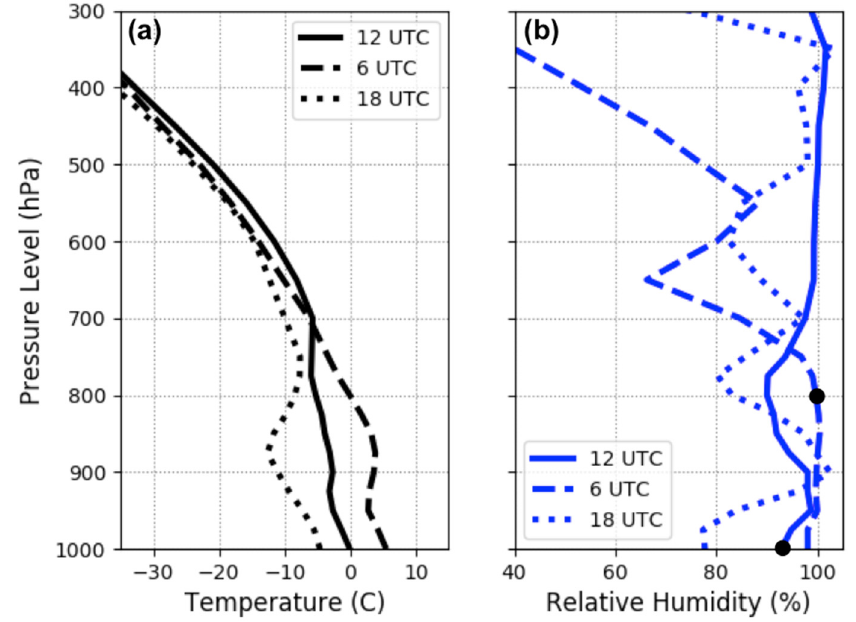
Figure 8. Profiles of temperature ( a ) and relative humidity ( b ) from the ERA5 reanalysis for 27 De- cember 2018 at 1200 UTC (solid line), 28 December 2018 at 0600 UTC (dashed line) and 1800 UTC (dotted line). The black dots in panel b signify the 0 °C level for the 1200 and 0600 UTC profiles.